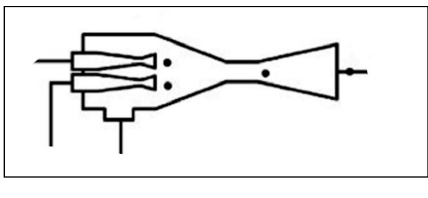
Figure 3. Dual-nozzle ejector [43].